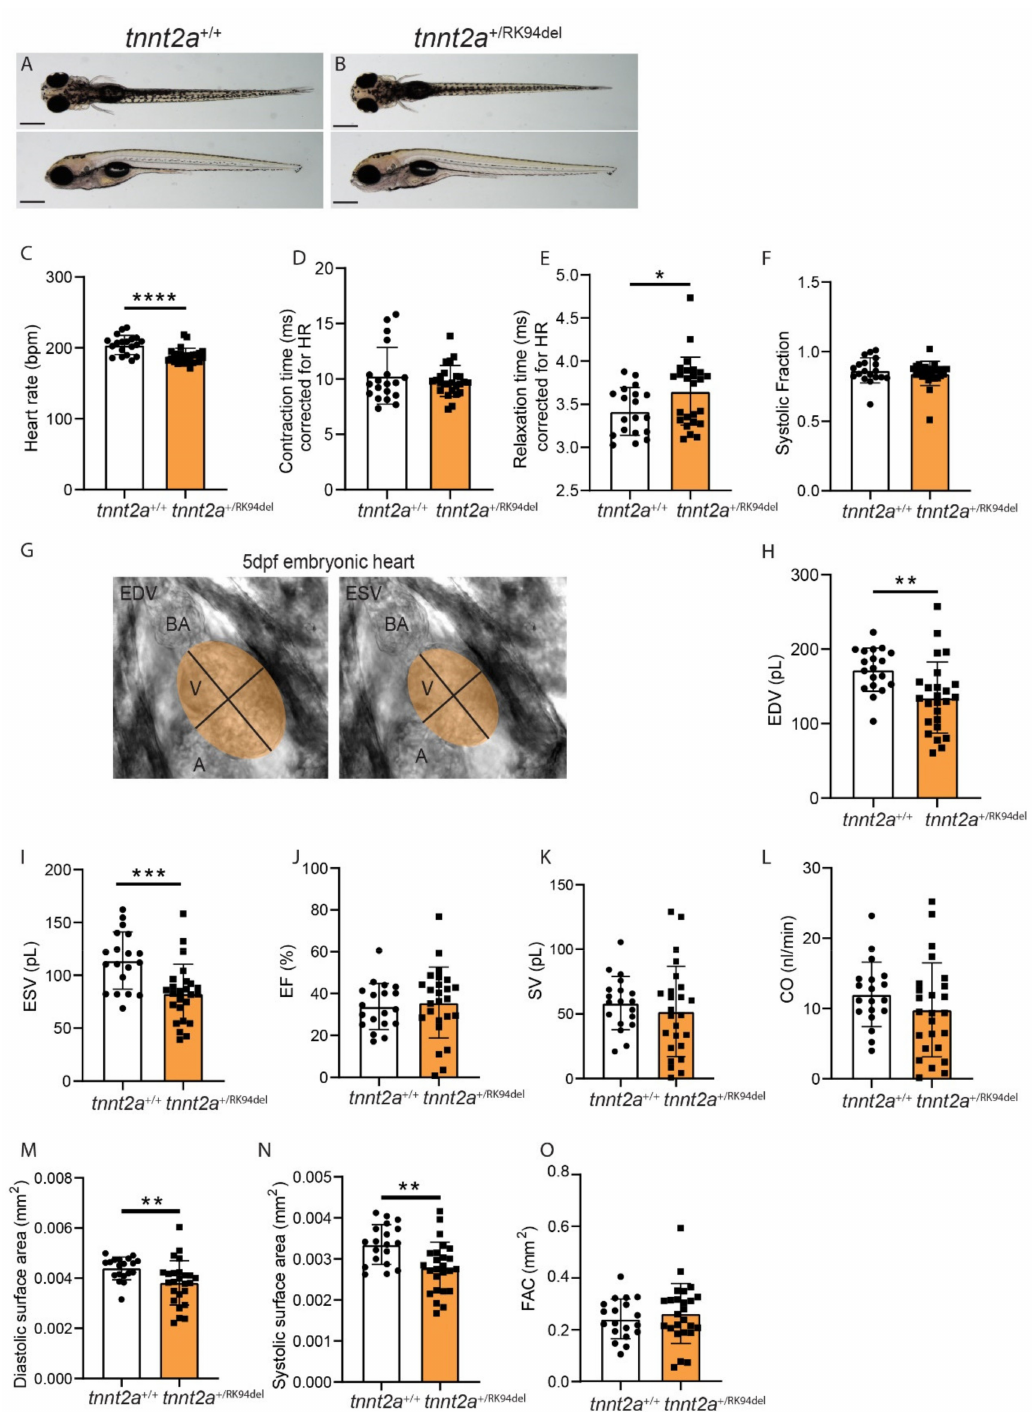
Figure 4. Embryos of tnnt2a +/RK94del show decreased heart rate accompanied by decreased ventricular diastolic and systolic volumes, as well as increased relaxation time. Side view and top view of 5 dpf ( A ) tnnt2a +/+ and ( B ) tnnt2a +/RK94del embryos. ( C – F ) Bar graph of contractility parameters, including heart rate, contraction time, relaxation time, and systolic fraction for tnnt2a +/+ and tnnt2a +/RK94del . ( G ) For hemodynamic parameters, we used ImageJ to fit an ellipse over the ventricle in every recording, both at end-diastole (left) and end-systole (right). ( H – L ) Bar graphs of hemodynamic parameters, including end-diastolic volume (EDV), end-systolic volume (ESV), ejection fraction (EF), stroke volume (SV), and cardiac output (CO). ( M – O ) Bar graphs of surface area parameters: diastolic surface area, systolic diastolic surface area, and fractional area change (FAC). Scale bar: 100 µ m. Statistics: mean ± SEM, * p ≤ 0.05, ** p ≤ 0.01, *** p ≤ 0.001, **** p ≤ 0.0001, tnnt2a +/+ n = 19, tnnt2a +/RK94del n = 24, unpaired Students